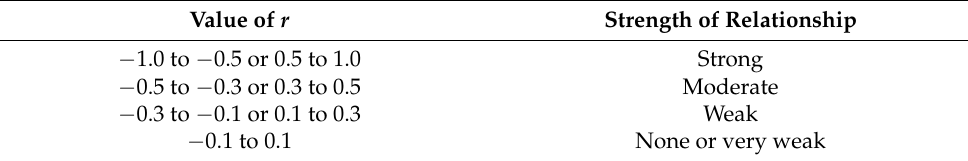
Table 1. Correlation